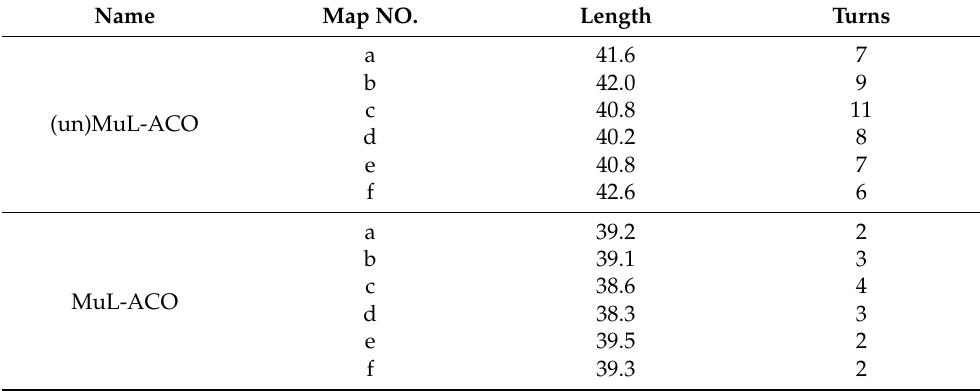
Table 6. Simulation results of (un)MH-ACO and